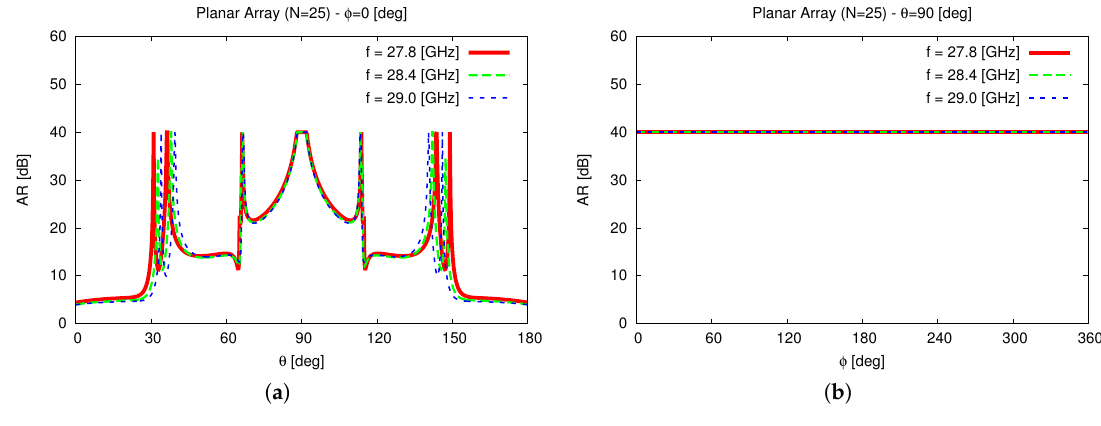
(cid:104) (cid:105) ( p ) ( p ) = [ 27.8, 29.0 ] (GHz))—Plot of the axial ratio, f , f max min ( p ) ( p ) = f ( p ) , f = f c , and f max along the ( a ) azimuthal (i.e., φ min